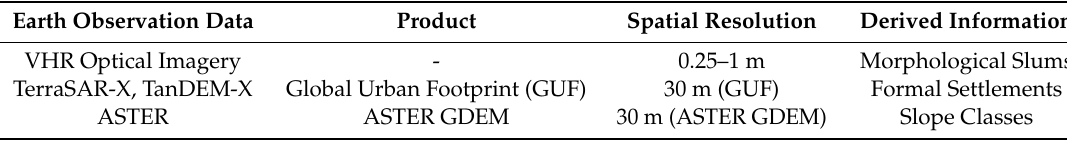
Table 1. Remote Sensing Data Details.